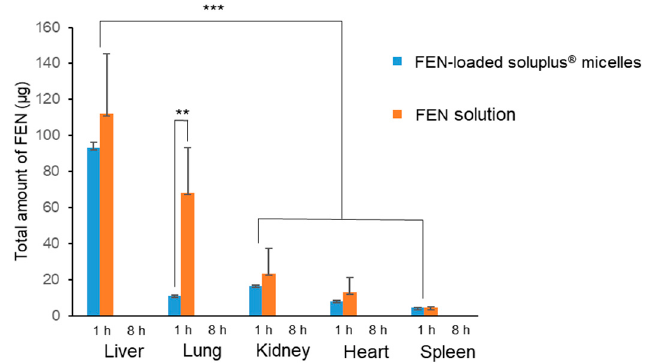
Figure 8. Total amount of fenbendazole (FEN) in each organ at 1 and 8 h after administration of FEN in 25% Cremophor EL ® /EtOH solution and FEN-loaded Soluplus ® micelles, ** p < 0.01, *** p < 0.001.